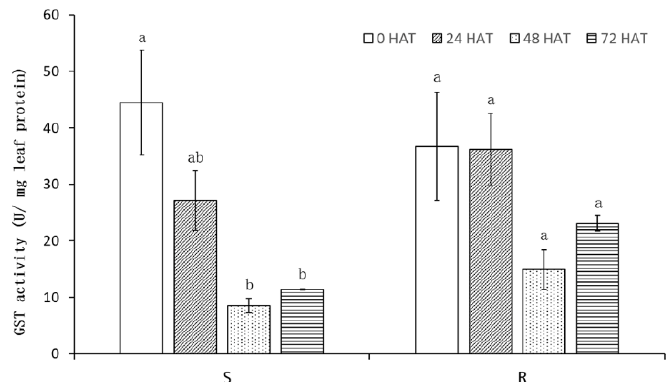
Figure 4. GST activity in S and R at 0, 24, 48, and 72 h after metsulfuron-methyl treated (HAT). Bars are mean ± standard error (n = 3). Values in a column followed by different letters are significantly different based on Fisher’s protected LSD test ( p ≤ 0.05).